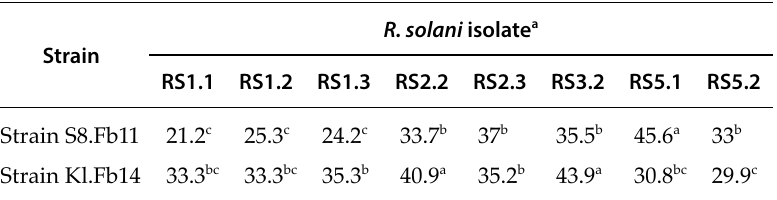
Table 2. Mean growth inhibition (%) of eight Rhizoctonia solani isolates in Petri-dishes antibiosis tests, by two bacterial strains from faba bean